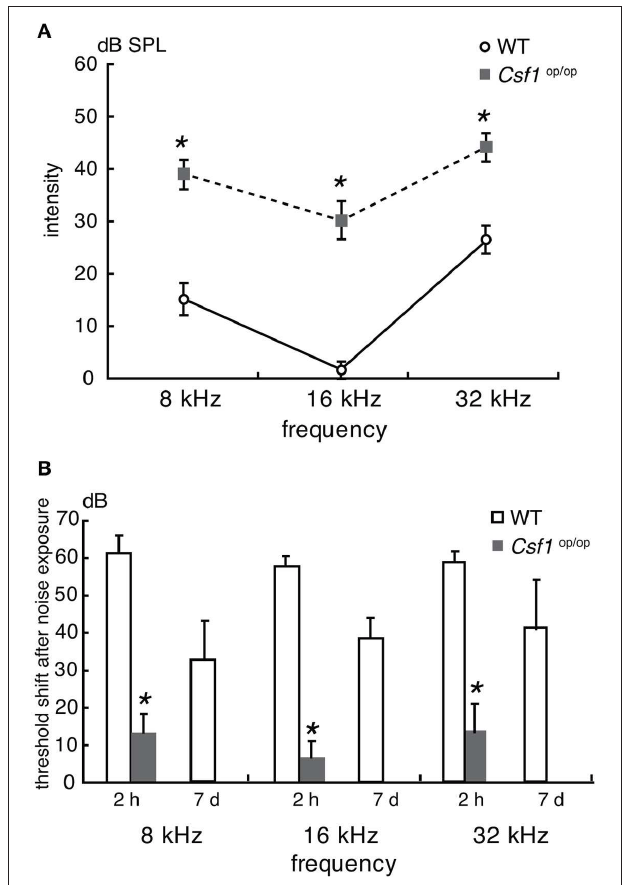
FIGURE 3 | Auditory brainstem response analyses revealed that Csf1 op / op mice have mild to moderate hearing loss. (A) Auditory brainstem response (ABR) thresholds (decibels of sound pressure level, dB SPL) were measured in 4-week-old Csf1 op / op mice and wild type ( WT ) littermates. Male and female mice were analyzed together. Csf1 op / op mice show a higher ABR threshold at 8, 16, and 32kHz, indicating that Csf1 op / op mice have mild to moderate hearing loss. (B) ABR thresholds were also measured 2h and 7 days after noise exposure to 8kHz octave band noise at 120 dB SPL for 1h. Csf1 op / op mice are less susceptible to acoustic overstimulation, and the difference in the threshold shift in ABR 2h after noise exposure compared with WT mice is statistically significant. Bars: mean ± SE. * p < 0.05.